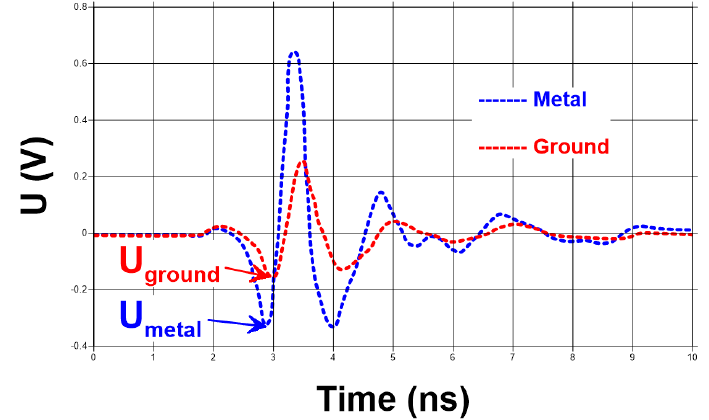
Figure 6. Example waveforms from the GPR system in Figures 3b and 5.